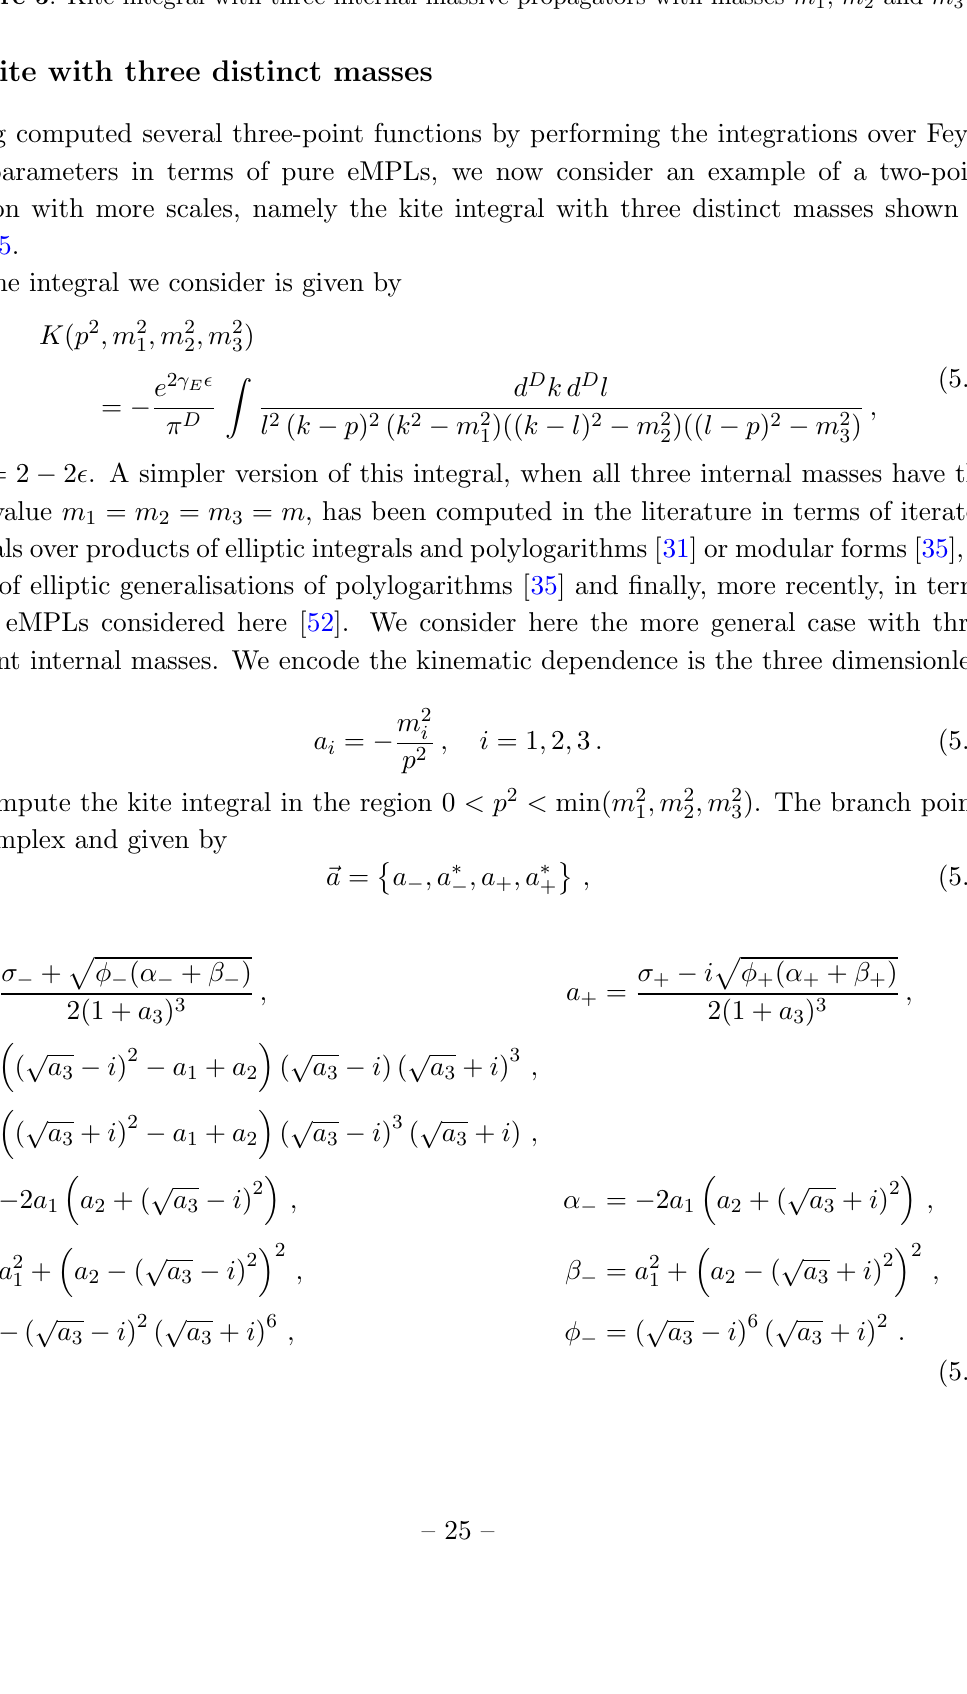
Figure 5 . Kite integral with three internal massive propagators with masses m 1 , m 2 and m 3